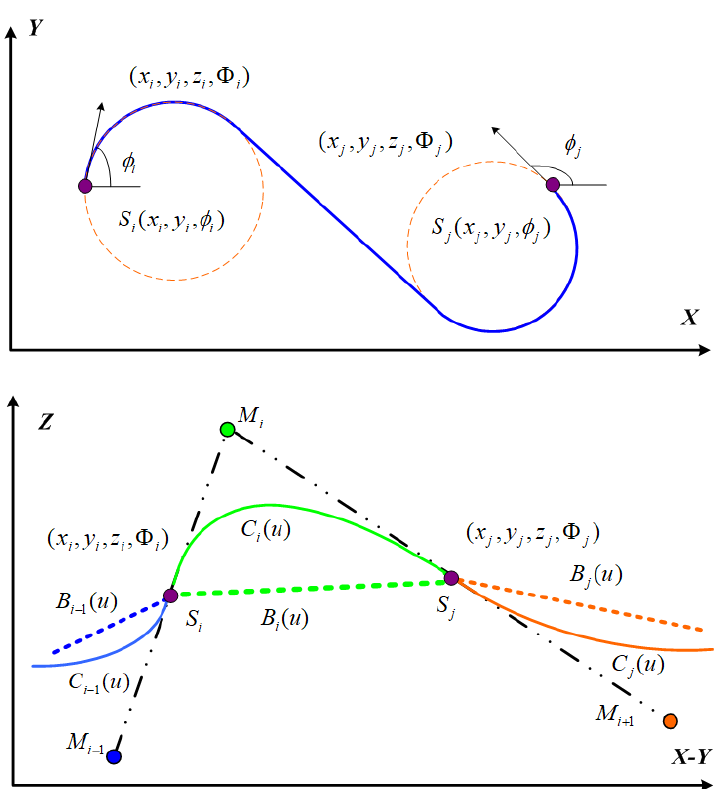
Figure 4. Two-dimensional (2D) and three-dimensional (3D) Dubins